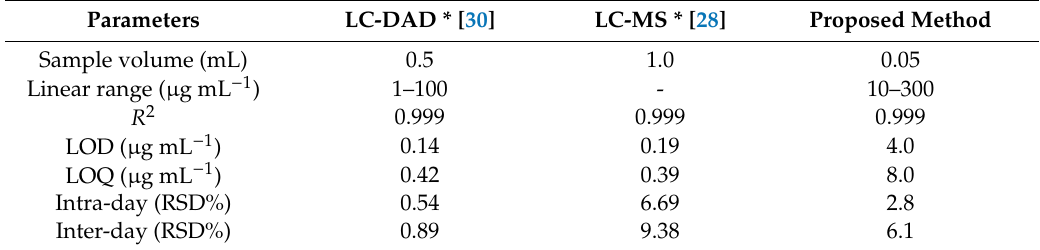
Table 3. Comparison of validation parameters methods for determination of TFV in urine sample.